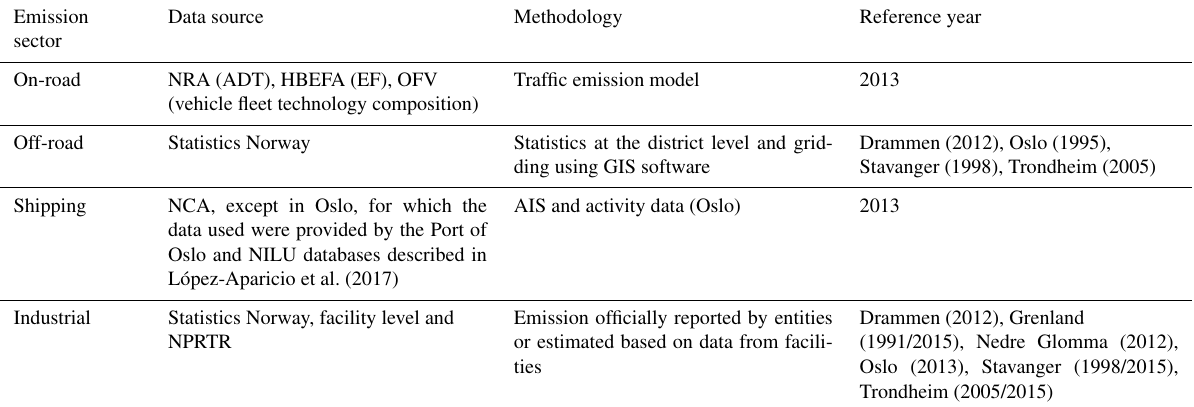
Table 4. A description of the data sources, the methodology used, and the reference years for the emission inventories for each emission sector used in the case studies. NRA: Norwegian Road Administration. OFV: Opplysningsrådet for Veitrafikken. HBEFA: Handbook Emission Factors for Road Transport. NCA: Norwegian Coastal Administration. NPRTR: Norwegian Pollutant Release and Transfer Registers.